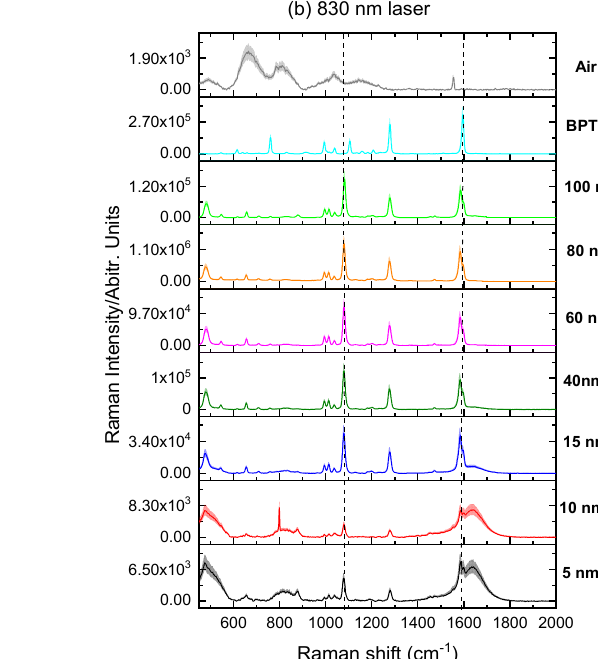
To assess the SERS signals for each individual label, the two dominant vibrational lines corresponding to the C–H rocking (1080 cm − 1 ) and in-plane stretching of the benzene rings (1380 and 1586 cm − 1 ) were selected [22].